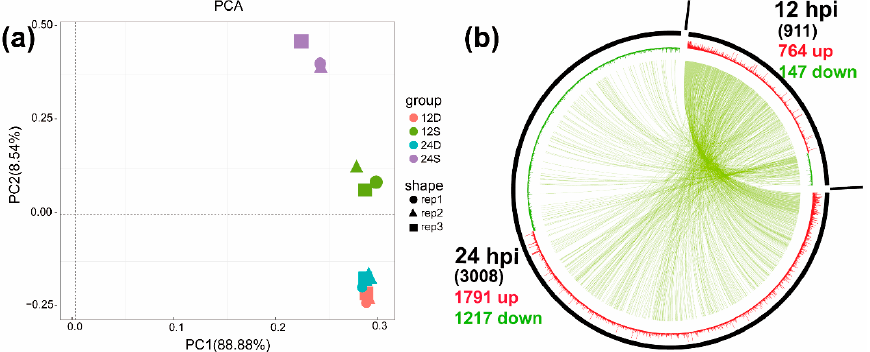
Figure 3. Principal component of samples ( a ) and visibility graph of differentially expressed genes ( b ) at 12 and 24 h post ‐ infection (hpi). Note: ( a ): PC1 shows the differences among duck Tembusu virus (DTMUV) ‐ infected samples; PC2 indicates differences between mock ‐ and DTMUV ‐ infected samples. 12D, mock ‐ infected DEFs at 12 hpi; 24D, mock ‐ infected DEFs at 24 hpi; 12S, DTMUV ‐ infected DEFs at 12 hpi; 24S, DTMUV ‐ infected DEFs at 24 hpi. ( b ): Upregulated differentially expressed genes (DEGs) are shown in red, whereas downregulated DEGs are shown in green. The green curve in the circle represents the common DEGs at 12 and 24 hpi.